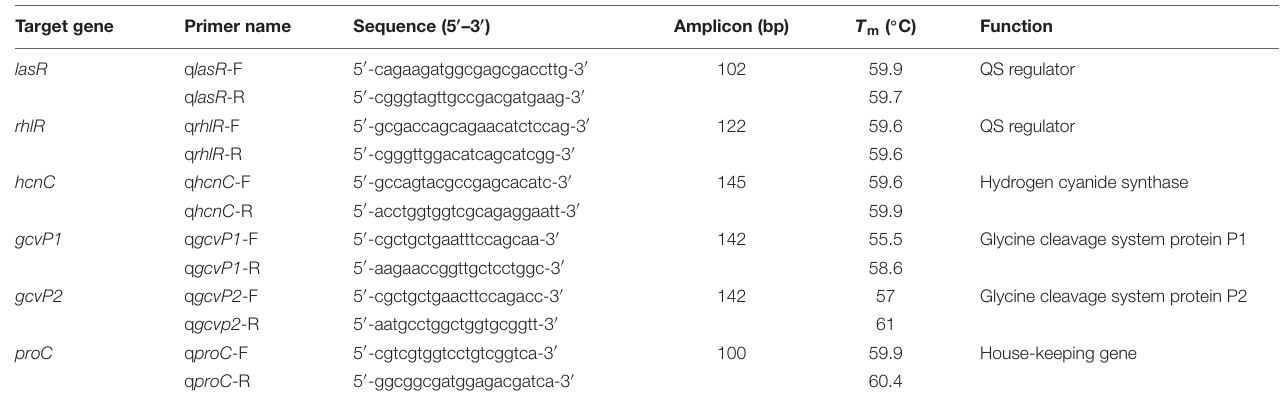
TABLE 1 | Primers used in this